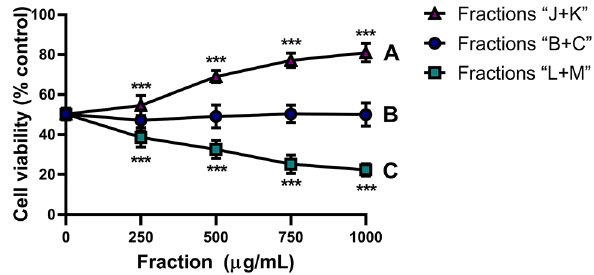
Figure 2. Effect of root extract fraction combinations on PC12 cell viability. Mean cell viability (± SD) measured by XTT assay of PC12 cells pretreated for 2 h with concentrations of combined root extract fractions (0–1000 μg/mL) ( A ) “J + K”, ( B ) “B + C”, or ( C ) “L + M” followed by 12 h of oxidative stress (400 μM H 2 O 2 ). Two- way ANOVA: fraction, p < 0.0001; concentration, p < 0.0001; interaction, p < 0.0001. Dunnett’s test: p = 0.0001, ***.